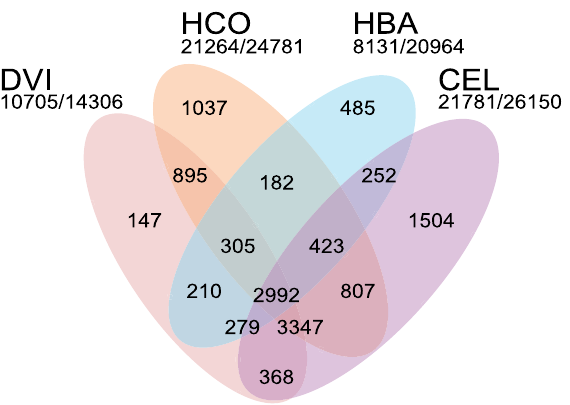
Figure 2. Comparison of the Dictyocaulusviviparus proteome to that of other rhabditid nematodes. Venn diagram illustrating the orthoMCL clustering of the predicted proteome of Dictyocaulus viviparus (DVI) to those of Caenorhabditis elegans (CEL), Heterorhabditis bacteriophora (HBA) and Haemonchus contortus (HCO). The numbers of proteins clustered and the total number of predicted proteins is given below each species’ name.